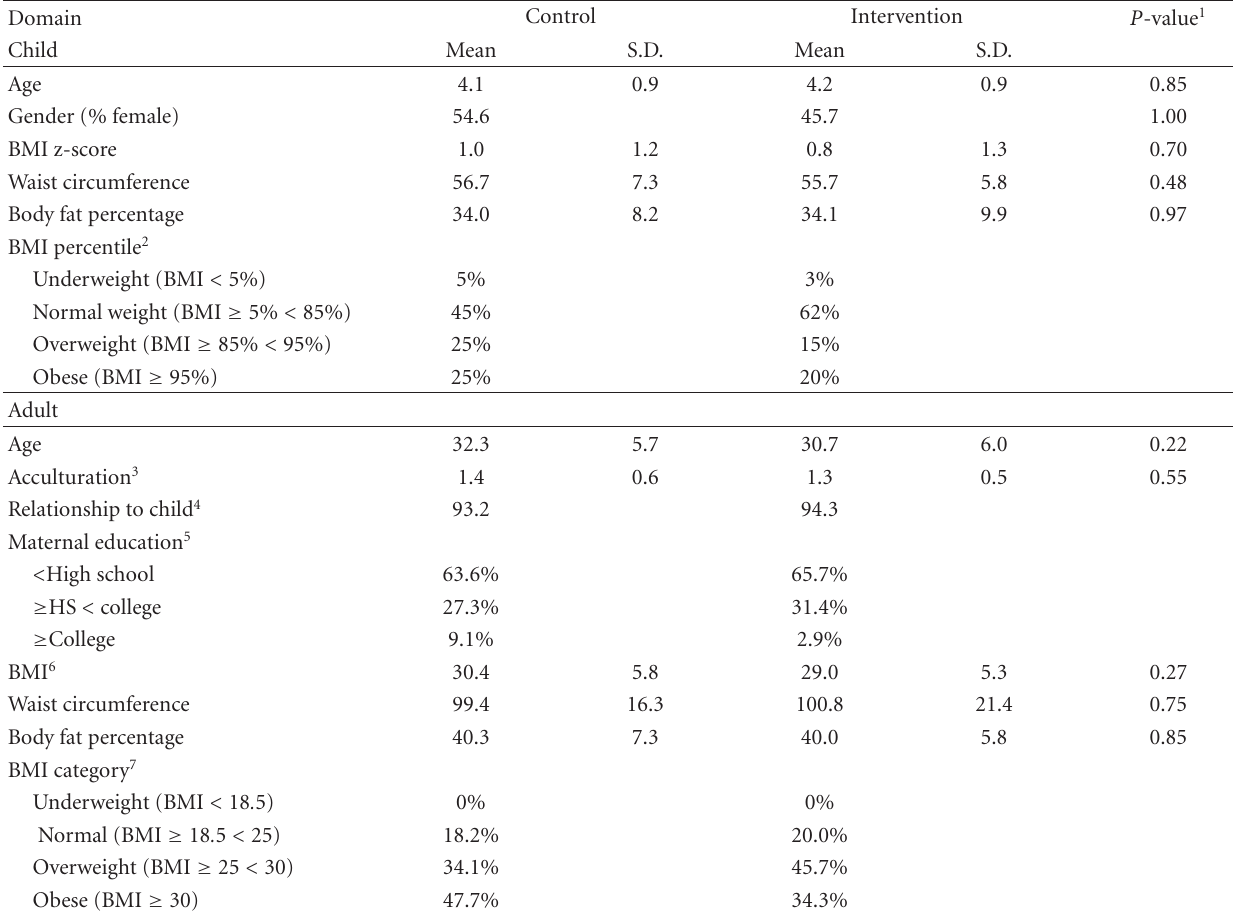
Table 3: Baseline demographic characteristics of latino parent-child dyads ( N =